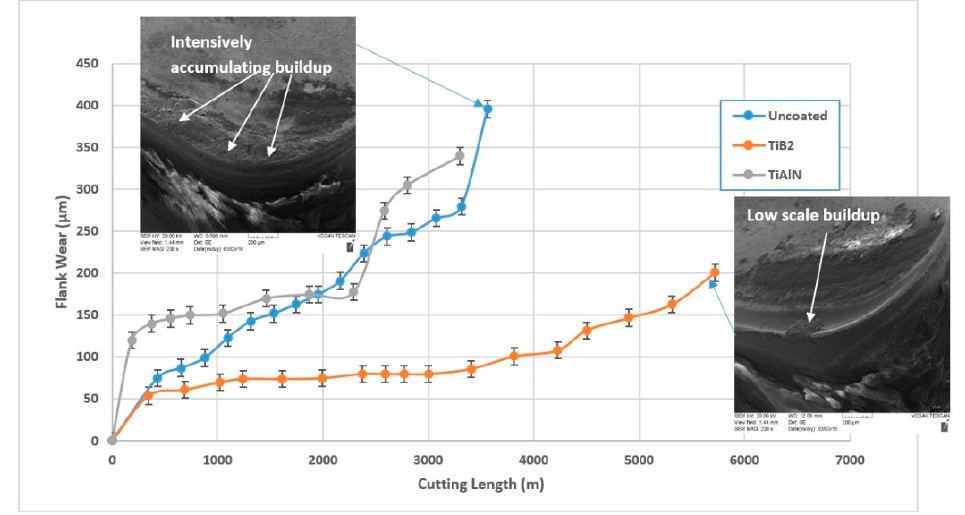
Figure 2. Tool life of TiB2 coated and uncoated tools after full-scale testing during rough turning of TiAl6V4 alloy. Reproduced from [28], with permission from Elsevier,